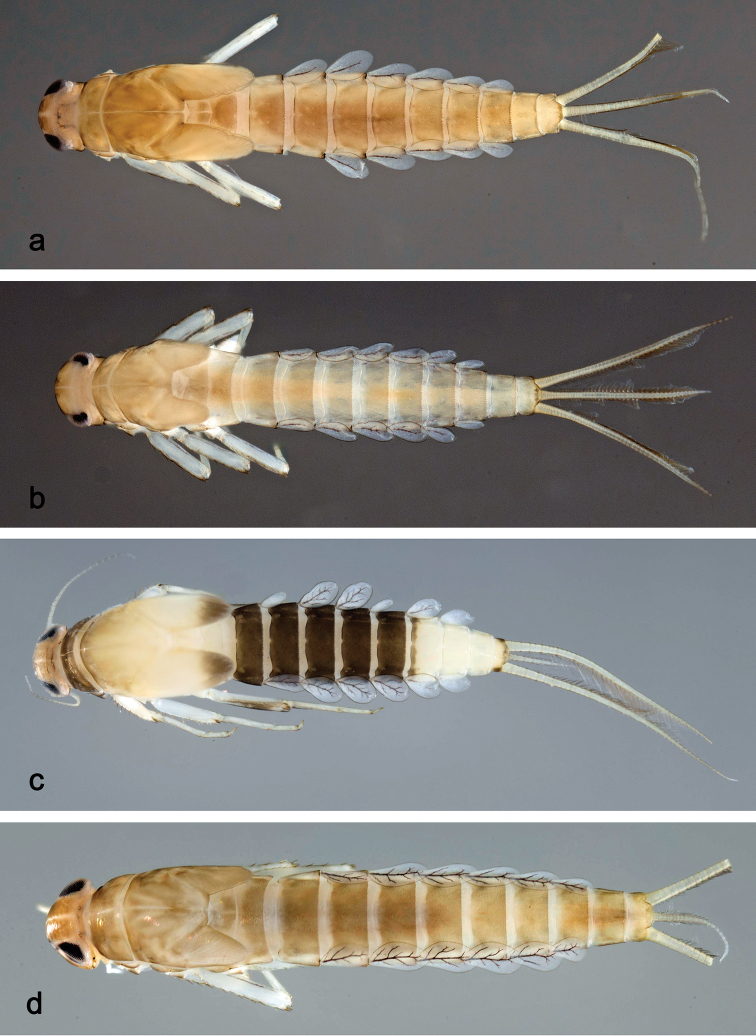
Habitus, larvae, dorsal view aLabiobaetis
freitagi sp. nov. bLabiobaetis
pelingeni sp. nov. cLabiobaetis
giselae sp. nov. dLabiobaetis
mendozai sp. nov.